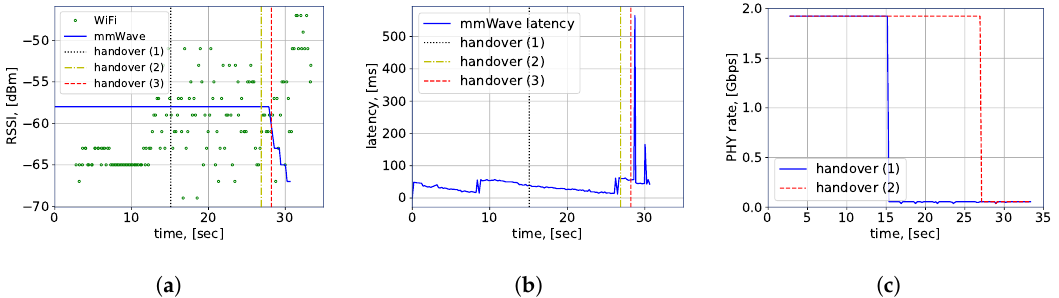
Figure 8. Measurements collected by the robot at the test scenario, ( a ) RSSI measurements; ( b ) WiGig latency measurements; ( c ) physical layer (PHY)